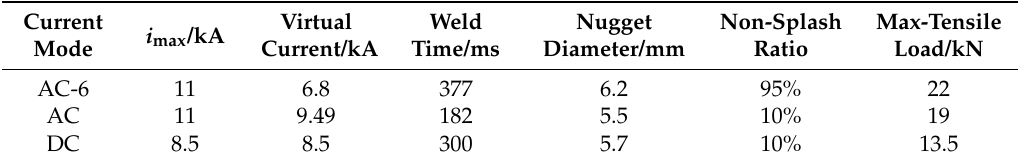
Table 2. Spot welding test results using three different current